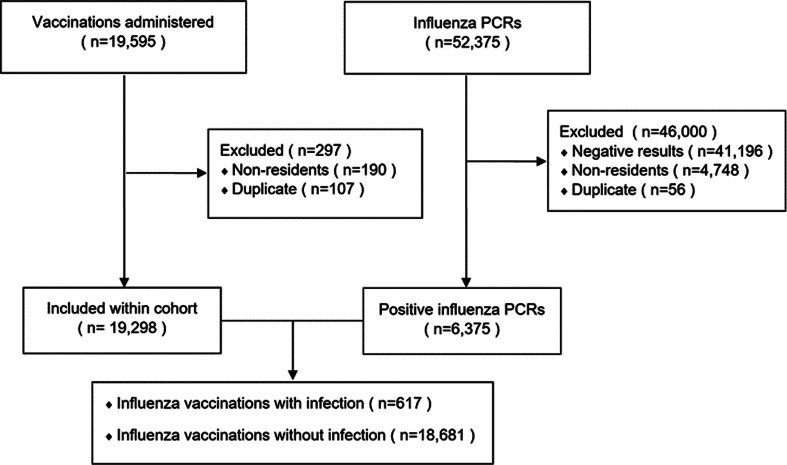
Flow diagram of study.